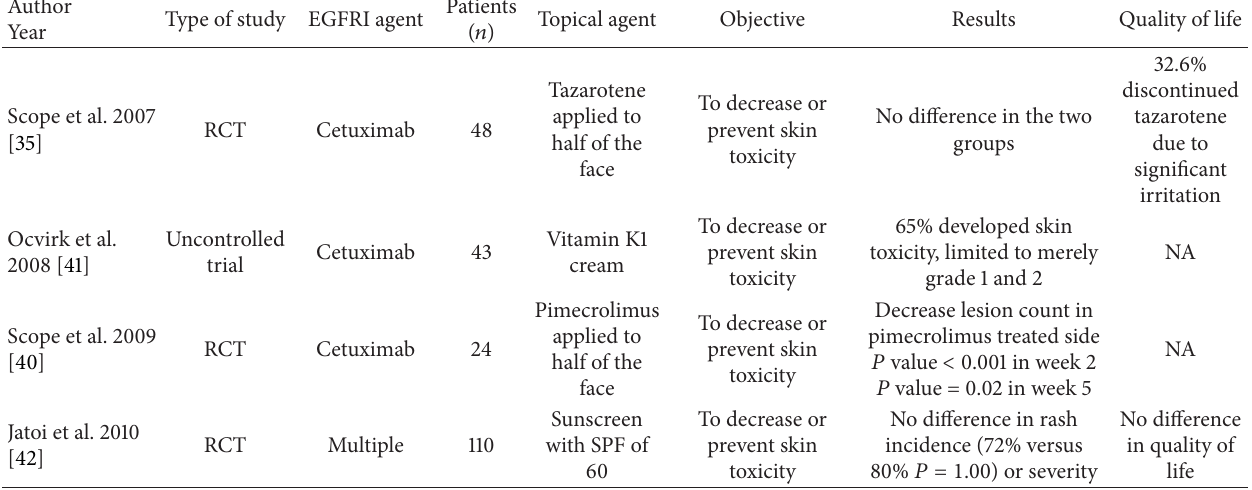
Table 2: Summery of topical treatment in the prevention of EGFRI-induced skin